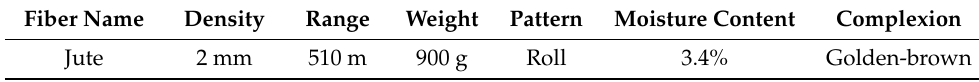
Table 1. The main characteristics of the jute fiber used in this